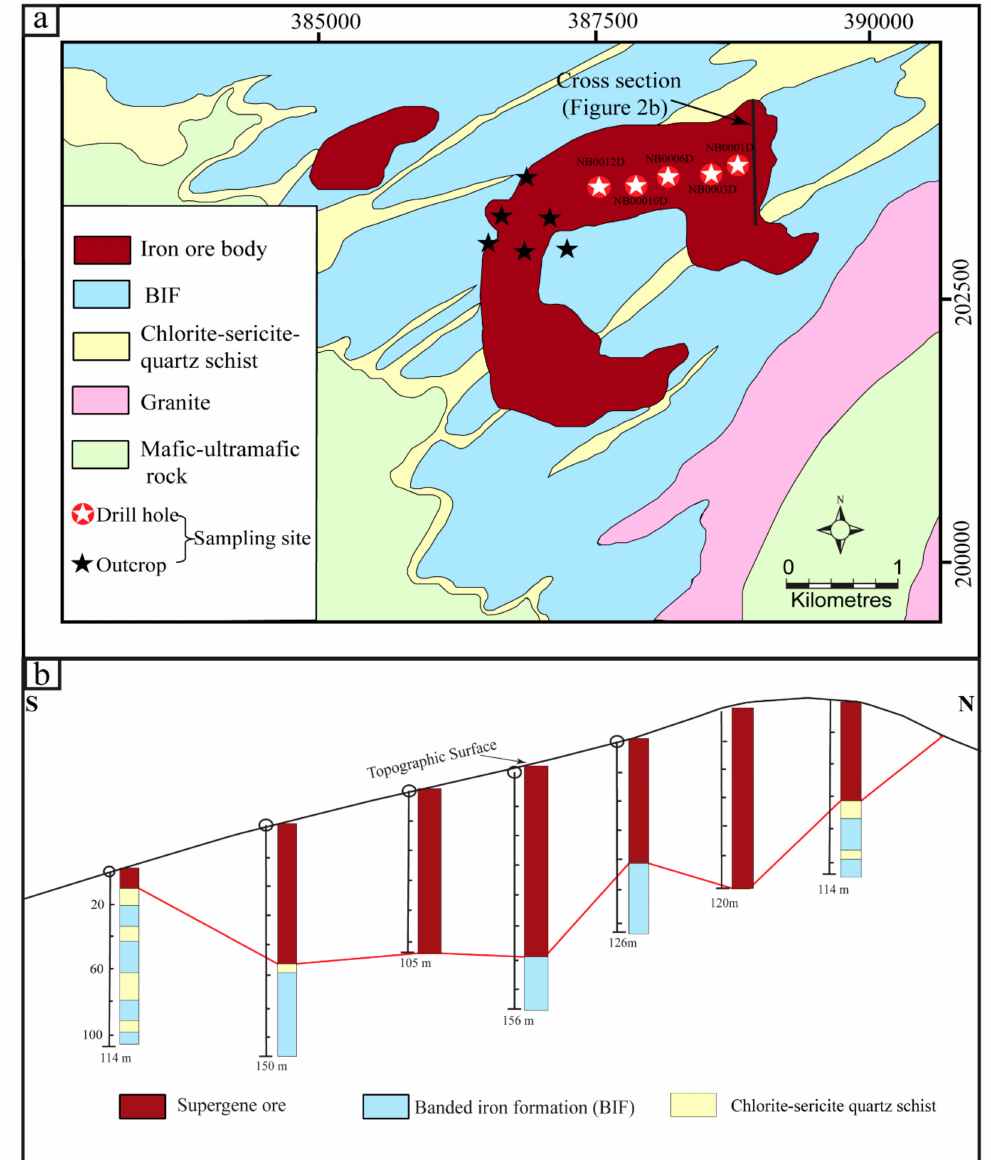
Figure 2. ( a ) Geologic map of the Nabeba Fe deposit modified from [16]), showing the sampling site; ( b ) geological profile of the deposit. NB0001D, NB0004D, and NB0012D are diamond drill-hole number at